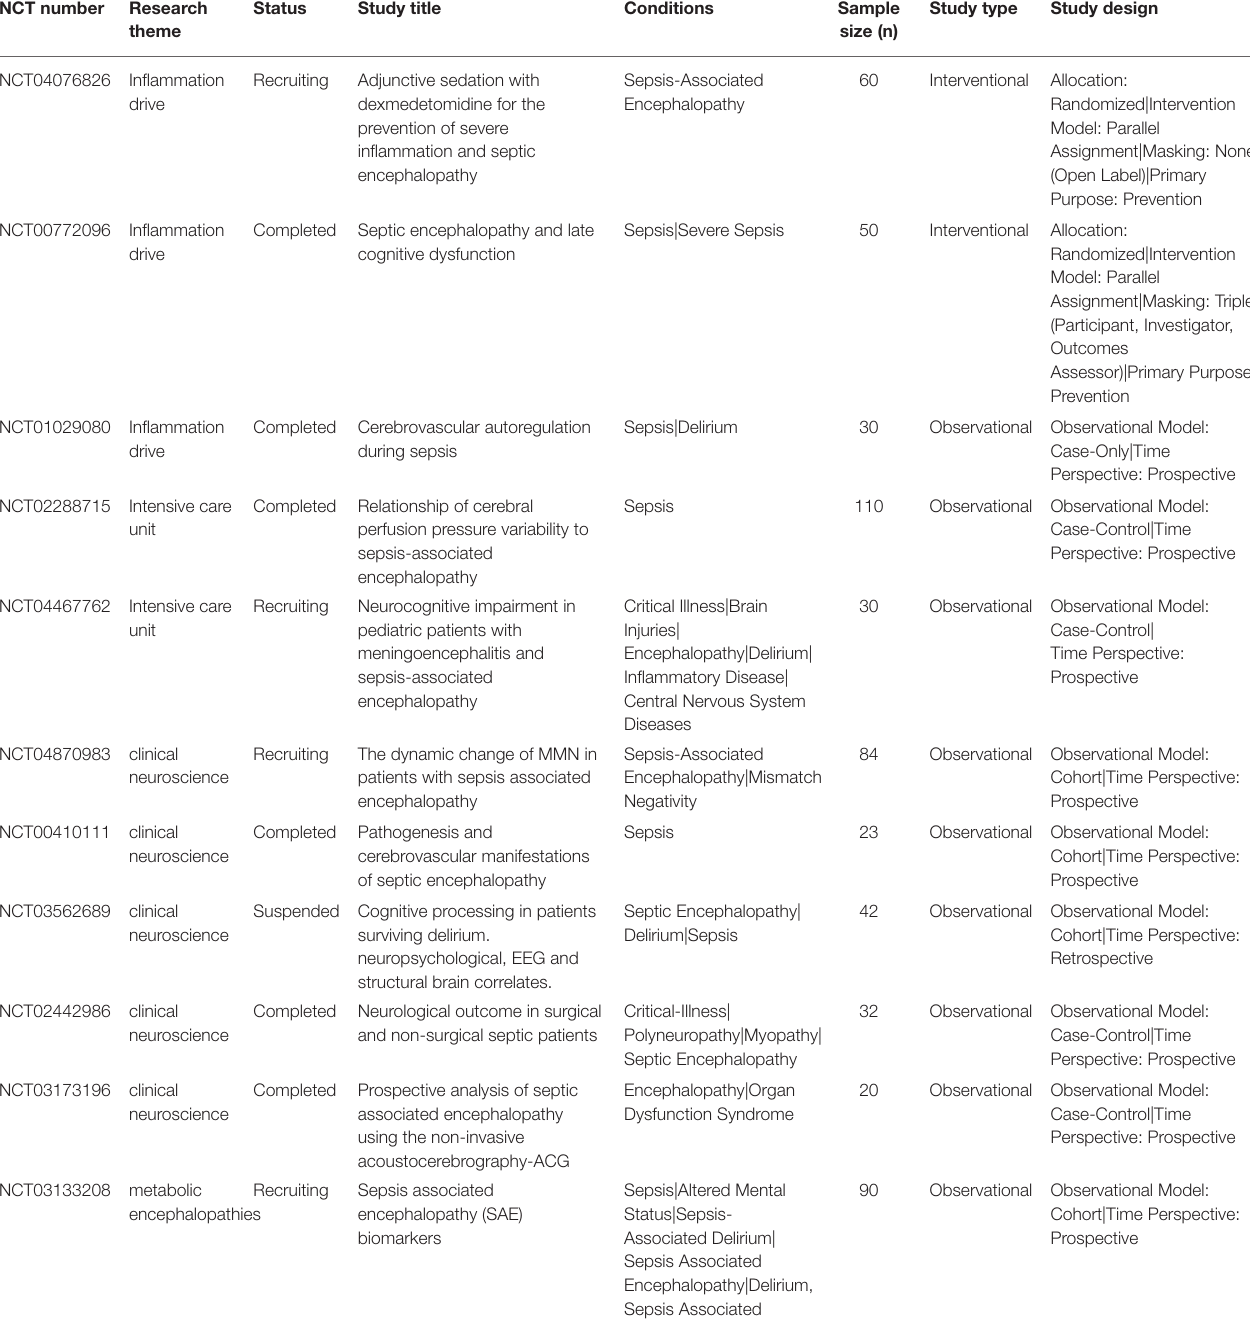
TABLE 2 | Eleven clinical trials exploring sepsis-associated encephalopathy that were registered with ClinicalTrials.gov. NCT number Research